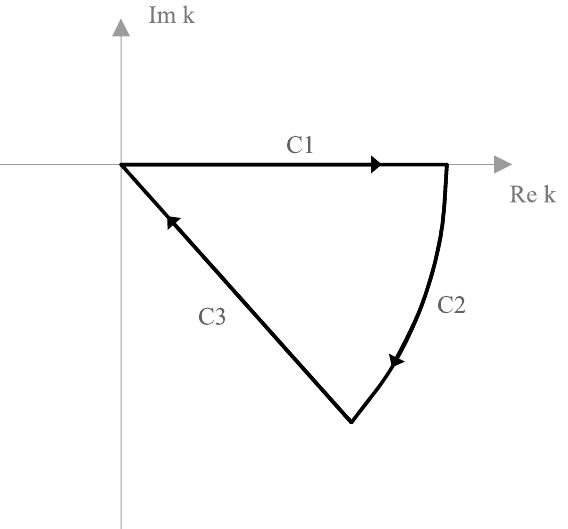
Figure 1. Path in the complex plane required to evaluate the continuum part of the Coulomb propagator. The value of the integral (39) along the real axis is given by the negative sum of the integral along C2 and C3: C1 = –(C2 + C3).